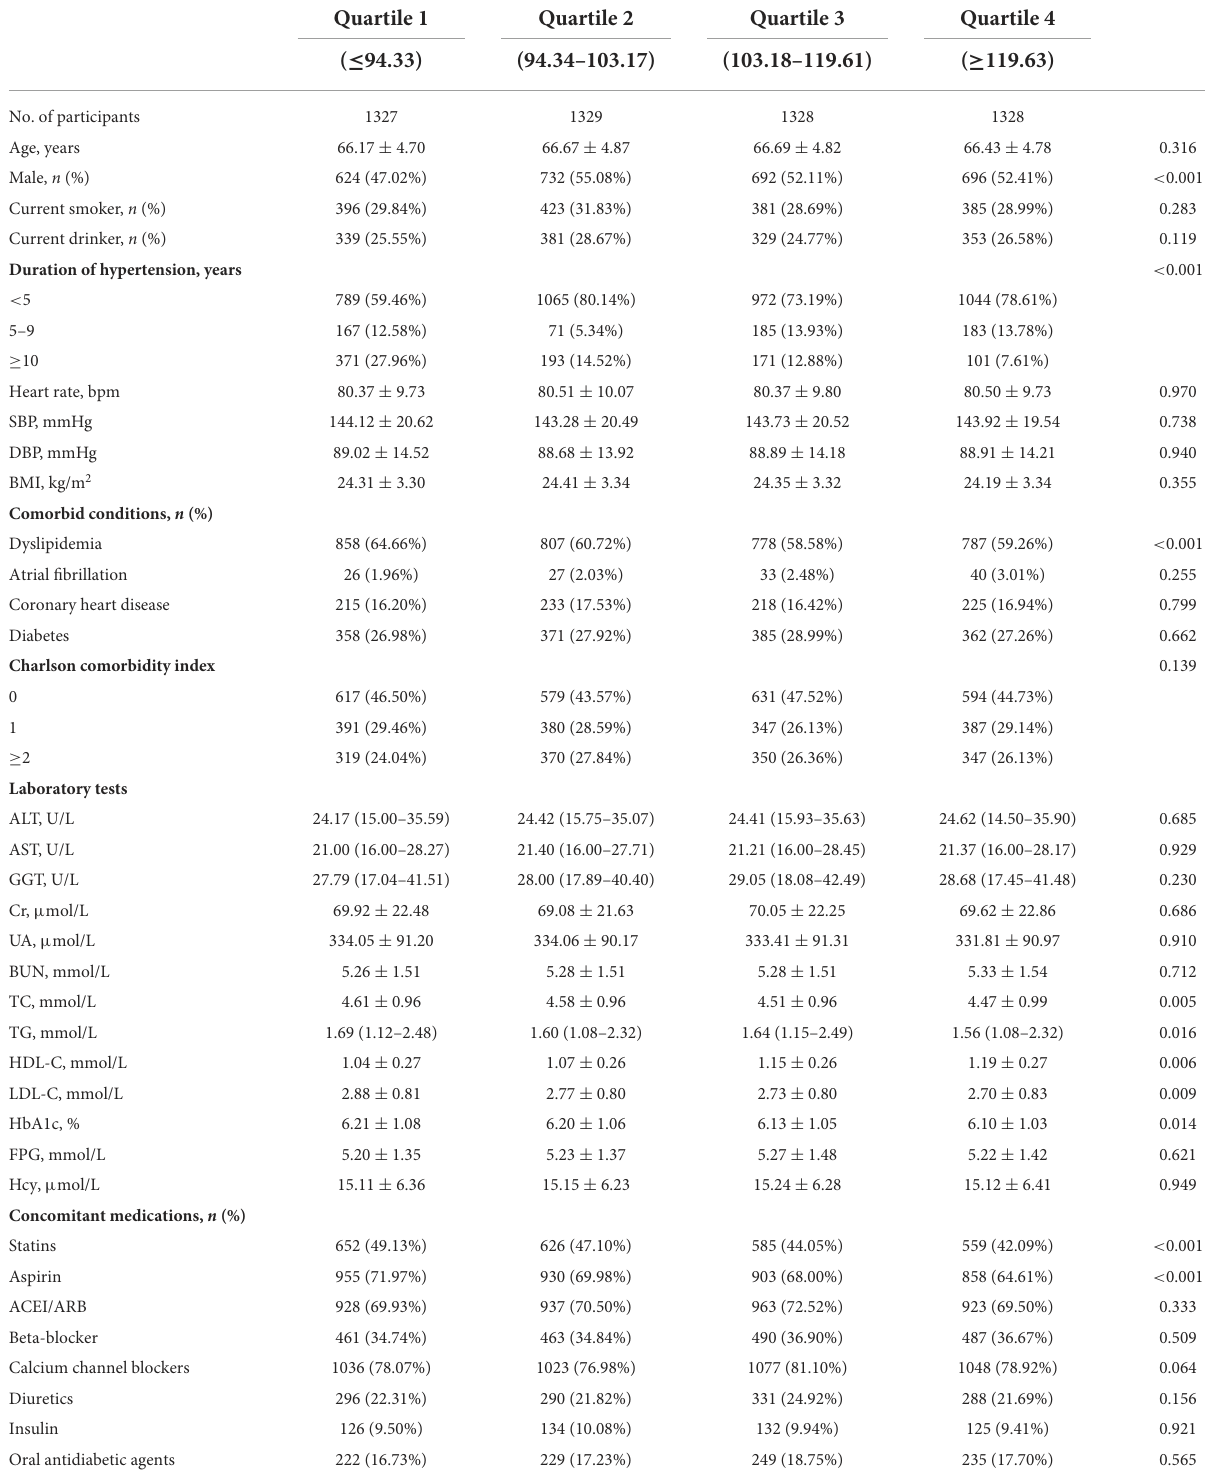
TABLE 1 Baseline characteristics stratified across quartiles of